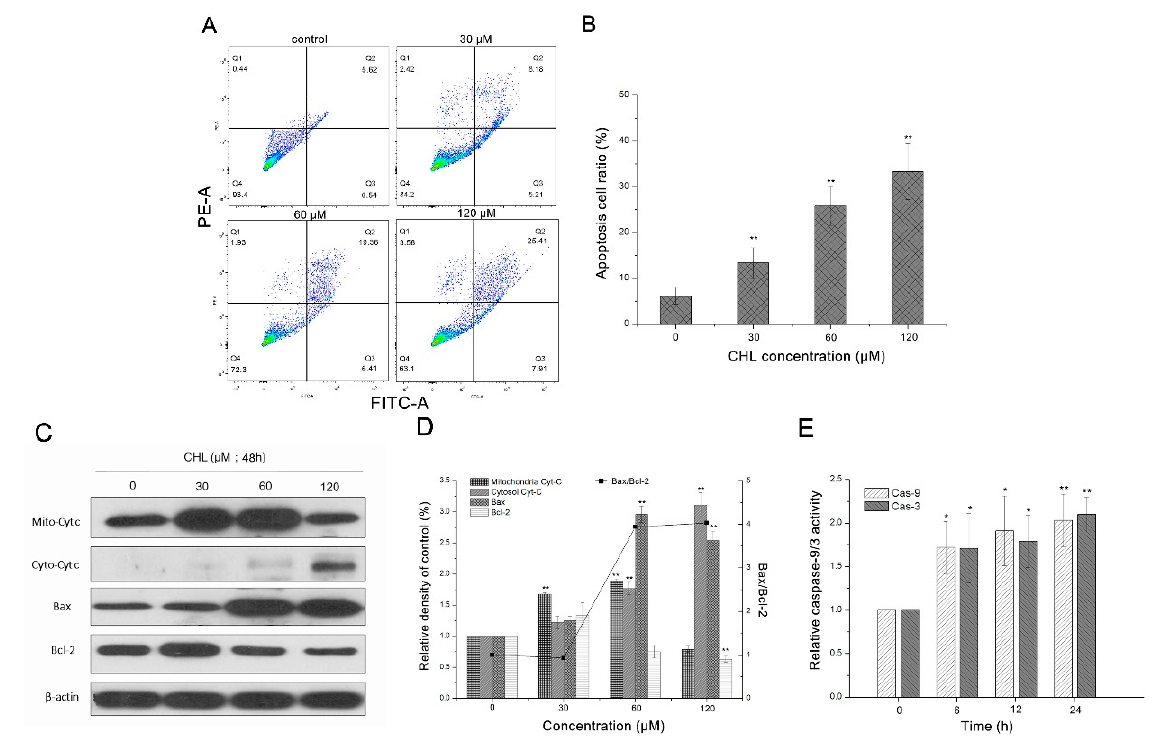
Figure 5. Analysis of apoptotic effects of HepG2 cells after treatment with CHL. ( A ): Analysis of Annexin V/PI staining by flow cytometry. ( B ): Quantification of apoptotic cells. ( C ): Expression of apoptotic proteins by Western blot. ( D ): Quantification levels of apoptotic proteins. ( E ): Evaluation of caspase-3/9 activity by spectrophotometric analysis. ** p ≤ 0.01 and * p ≤ 0.05 vs. the negative